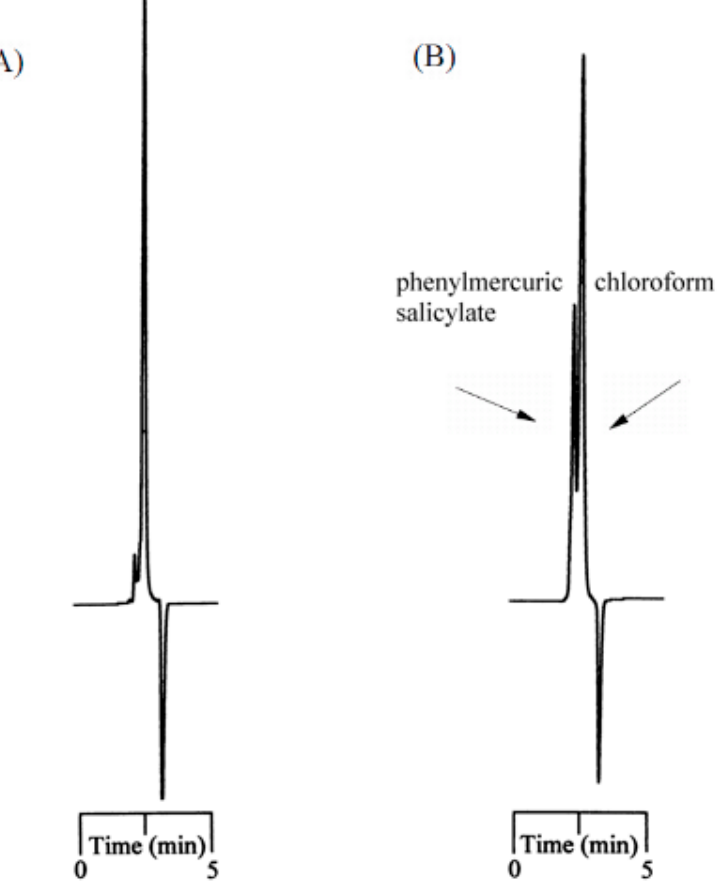
Figure 7. Chromatograms for the elution of phenymercuric salicyalte after ( A ) and before ( B ) adsorption on the lignin-modified silica gel in chloroform using the mobile phase of 491/10/1/2 by volume (acetonitrile/methanol/acetic acid/triethylamine, v/v ). The UV detection wavelength was set at 259 nm.